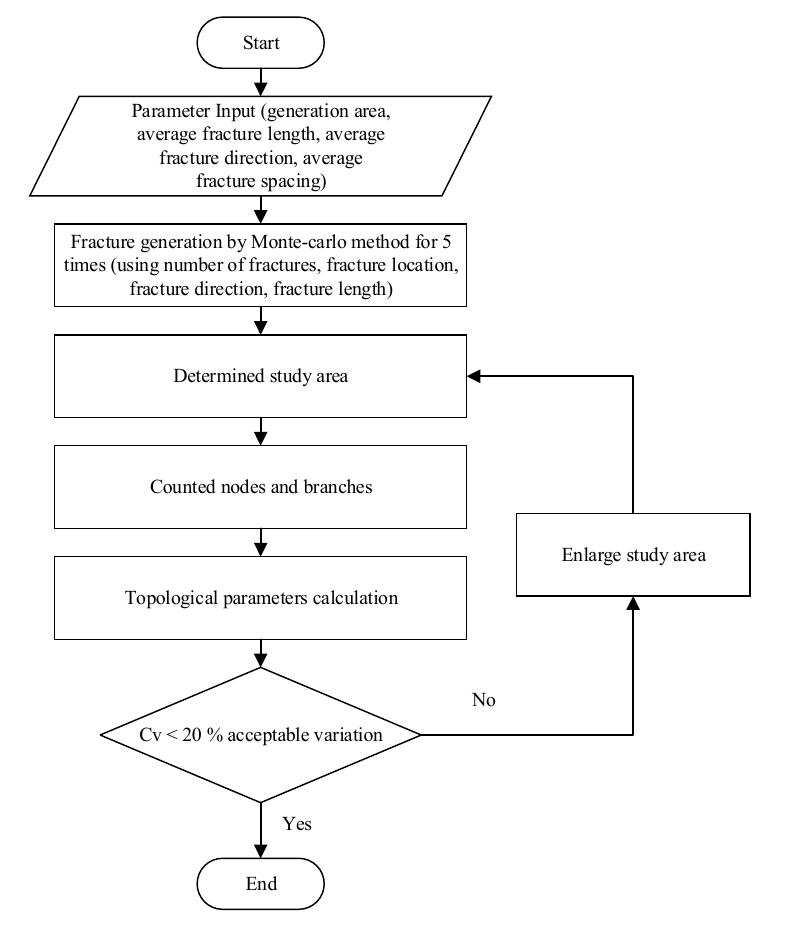
Figure 2. The workflow chart of TREV calculation.